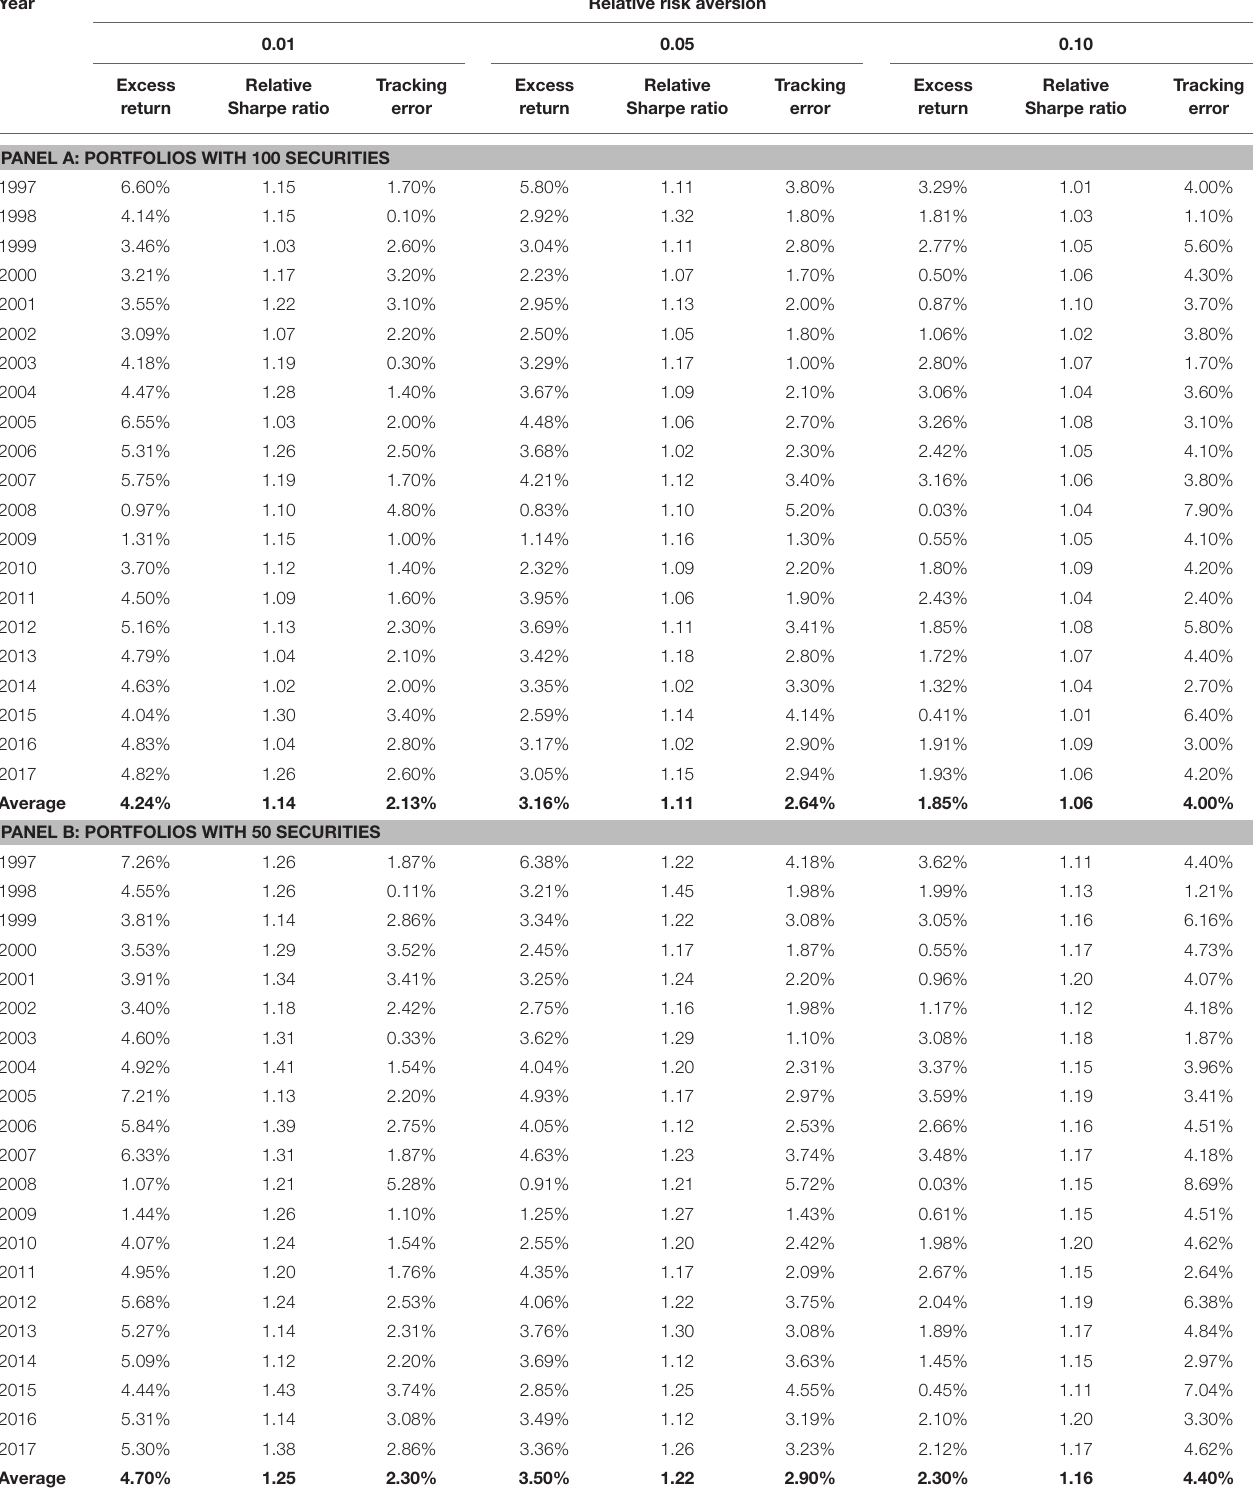
TABLE 1 | Portfolio Statistics for the USER